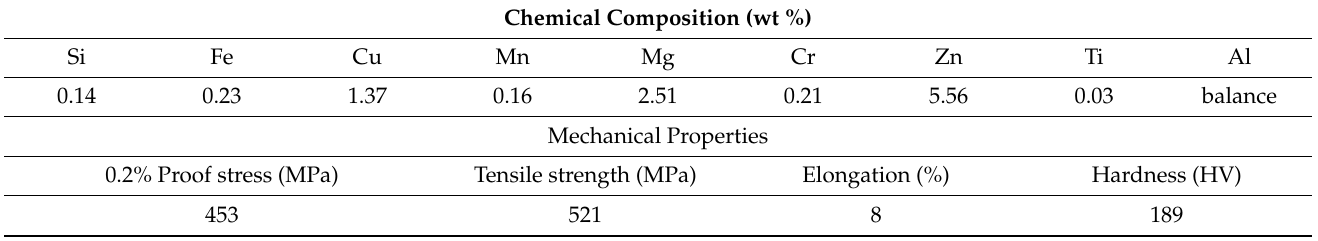
Table 1. Chemical composition and mechanical properties of the used AA7075 aluminum plate.